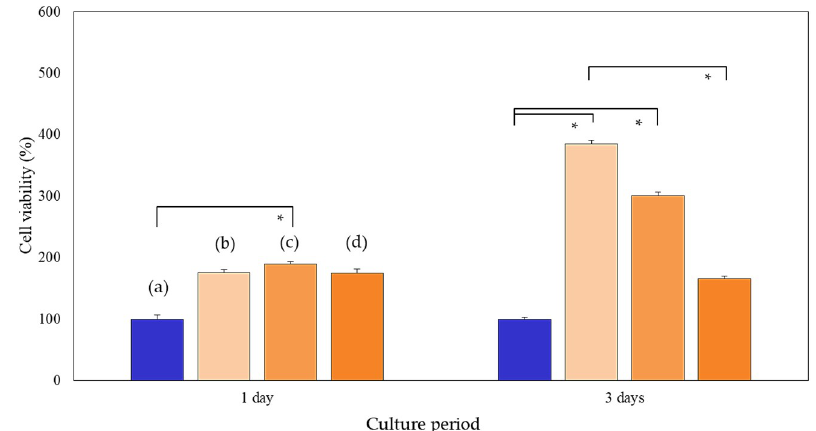
Figure 8. Cell viability of MC3T3‐E1 on Ti (a) untreated and subjected to (b) NaOH‐CaCl 2 ‐heat‐Sr, (c) NaOH‐CaCl 2 ‐heat‐Sr + 1 mMAg (pH = 4), and (d) NaOH‐CaCl 2 ‐heat‐Sr + 10 mM Ag (pH = 4). Asterisk stands for statistically significant difference ( p < 0.05).